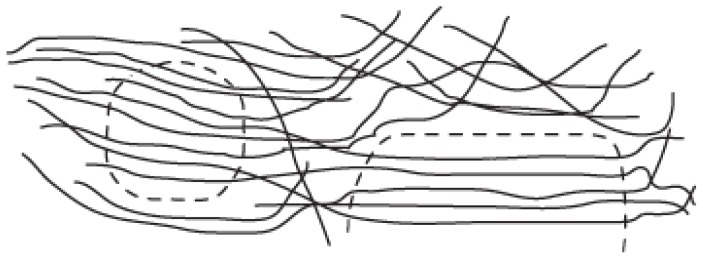
Schematic of the ordered and disordered regions [26].